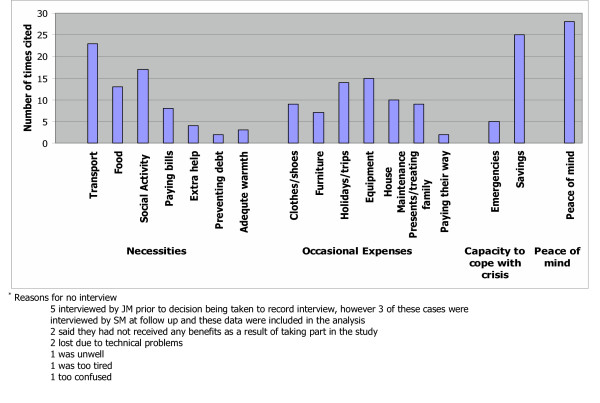
Use of additional resources at 2 year follow up (N = 35)*.